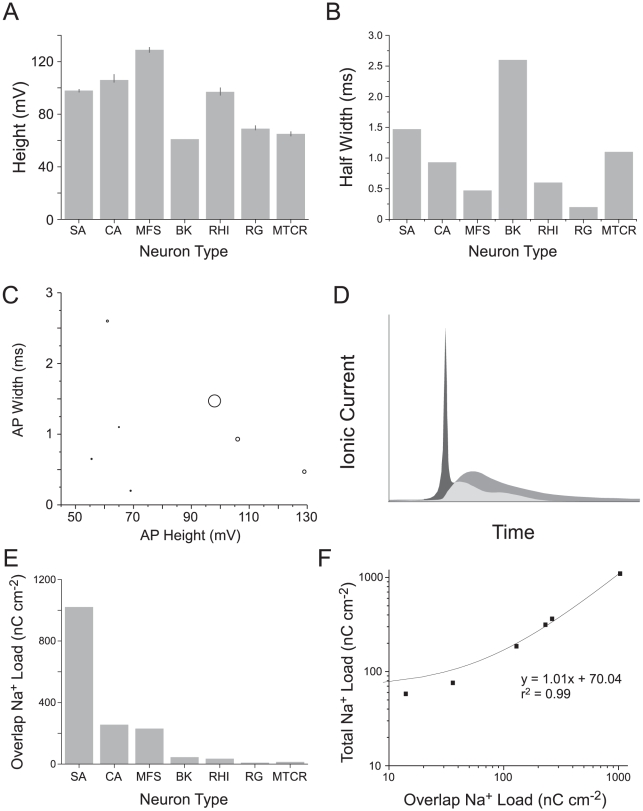
The overlap between Na+ and K+ currents affects action potential efficiency.(A) The heights of action potentials in the seven models. Error bars show the effect on AP height of changing the peak conductances of the voltage-gated ion channels by ±5%. (B) The half widths of action potentials in the seven models. Error bars are not visible because changing the peak conductances of the voltage-gated ion channels by ±5% did not affect AP width. (C) The relationship between the height, width and Na+ load of action potentials from each of the models shown in Figure 1. The size of each circle is proportional to the energy consumed by the action potential. (D) Schematic diagram of the ionic charge distributions of an action potential depolarizing charge (horizontal lines), overlap charge (hatched) and hyperpolarizing charge (vertical lines). (E) The overlap charge in action potentials from each of the seven models. (F) The relationship between the overlap charge and the total Na+ load. SA, squid giant axon; CA, crab motor neuron; MFS, mouse fast spiking neuron; BK, honeybee Kenyon cell; RHI, rat hippocampal interneuron; RG, rat granule cell; MTCR, mouse thalamocortical relay neuron.